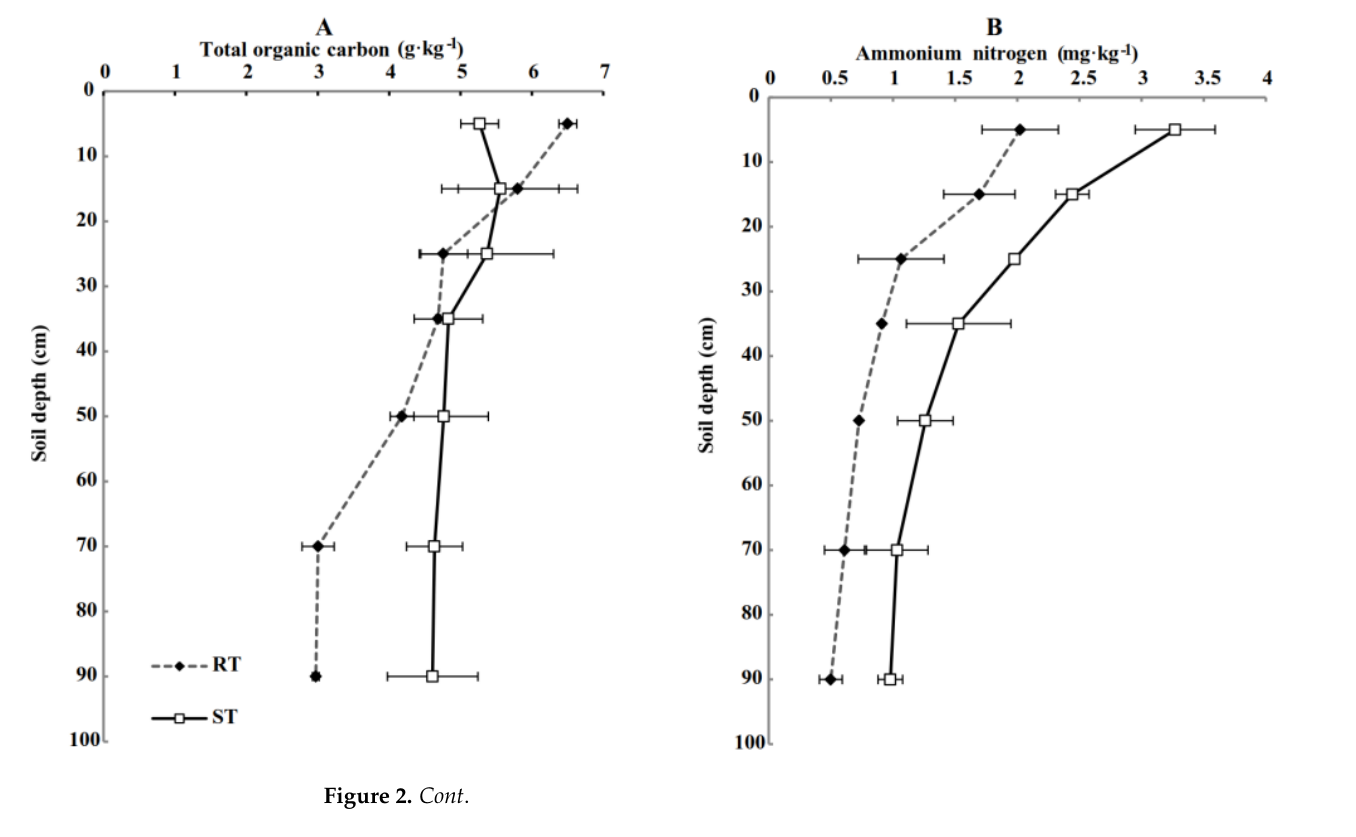
Figure 1. Effect of tillage methods on soil compactness at 0–45 cm (( A ) moderate moisture; ( B ) low moisture). Data are mean ± standard deviation ( n = 3).